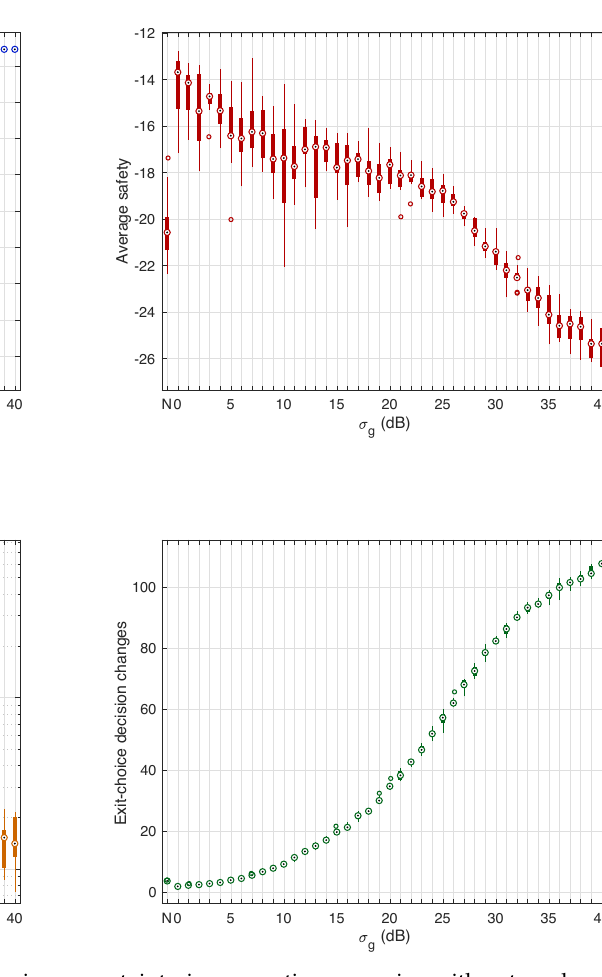
Figure 9. Sensitivity analysis of the positioning uncertainty in evacuation scenarios with external pedestrian flows. The box-plots on the first row show the sensitivity of evacuation time and average safety to standard deviation values σ g in the range 0 dB to 40 dB. The second-row plots show the sensitivity of safety variance and the number of decision changes to the standard deviation values σ g . In the four box-plots, σ g = N represents an evacuation scenario in which pedestrians do not use